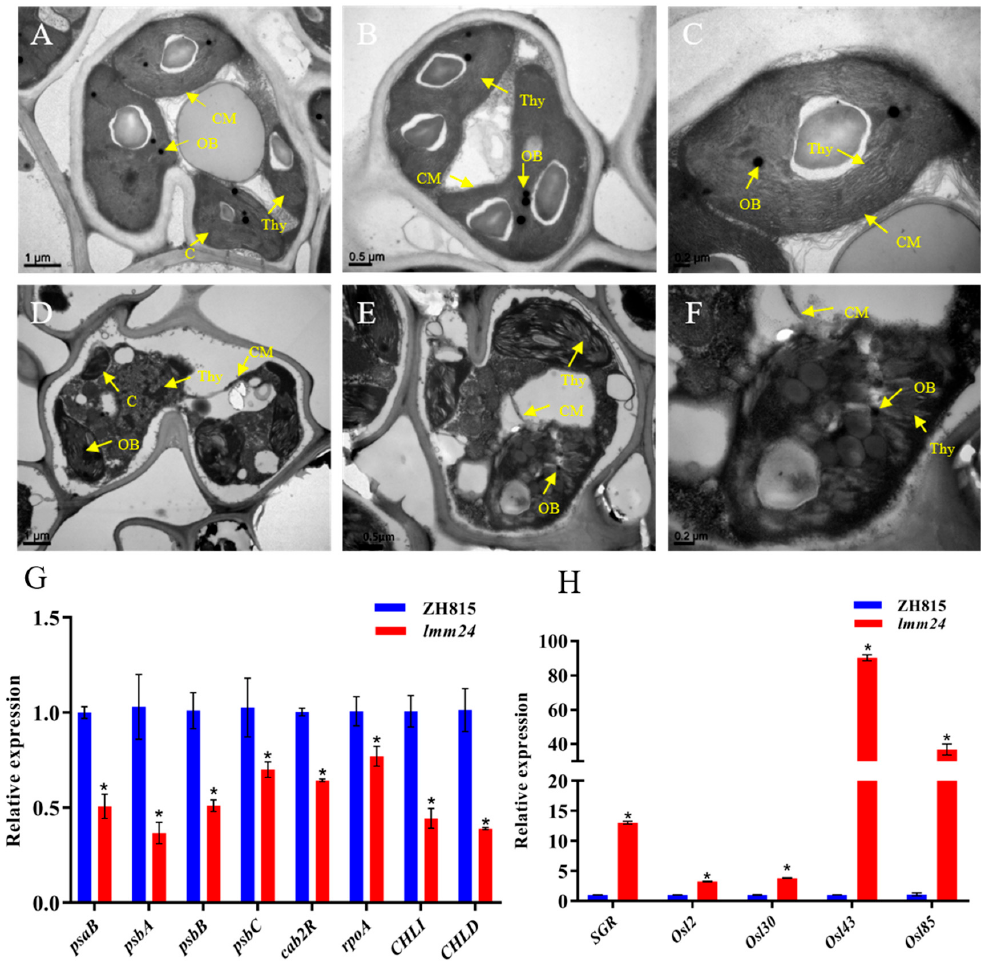
Figure3. QualitativeTEMobservationandgenesexpressionanalysis. ( A – C Figure 3. Qualitative TEM observation and genes expression analysis. ( A – C ) Observation of